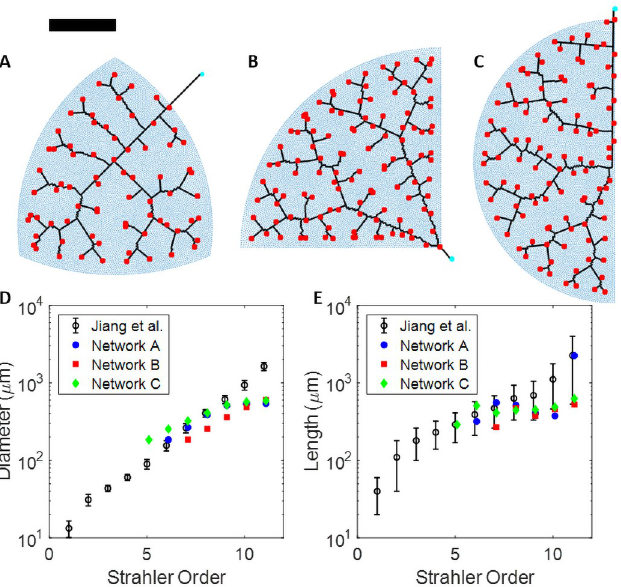
Fig 3. Morphometrically realistic pulmonary vascular networks. (A,B,C) Synthetic population of rat lungs. Blue dots are the finite-element mesh points made by Polymesher [34], the cyan circles denote the root node for each network, the black lines represent the network topology, and the red squares denote the network terminals. The black scale bar is 3000 μ m. All networks were made with 1,000 nodes and Δ g set to 50 μ m. Note that the radius of each vessel is not plotted to size. The total area spanned by each finite element mesh is the same. (D, E) Comparison of our network geometries to measured diameters and lengths as a function of diameter-defined Strahler orders from silicone- elastometer casts of rat pulmonary arterial trees in Jiang et al.